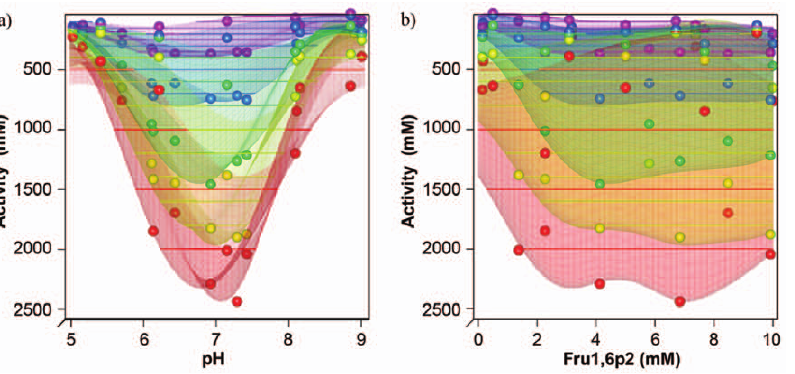
Figure 4. Influence of pH and Fructose 1,6-bisphosphate on PYK activity at different substrate (PEP) concentrations. a) and b) show two different perspectives of the same plot. Each colour represents one PEP concentration. 0.25 mM is shown in red, 0.5 mM in yellow, 1 mM in green, 2 mM in blue and 4 mM in purple. Note the complex pattern of interactions and how the pH optimum shifts toward a more acidic pH at low substrate concentrations. Due to the relatively low number of measurements, it is not completely possible to exclude fitting artefacts as a source of variability of the fitted surfaces.